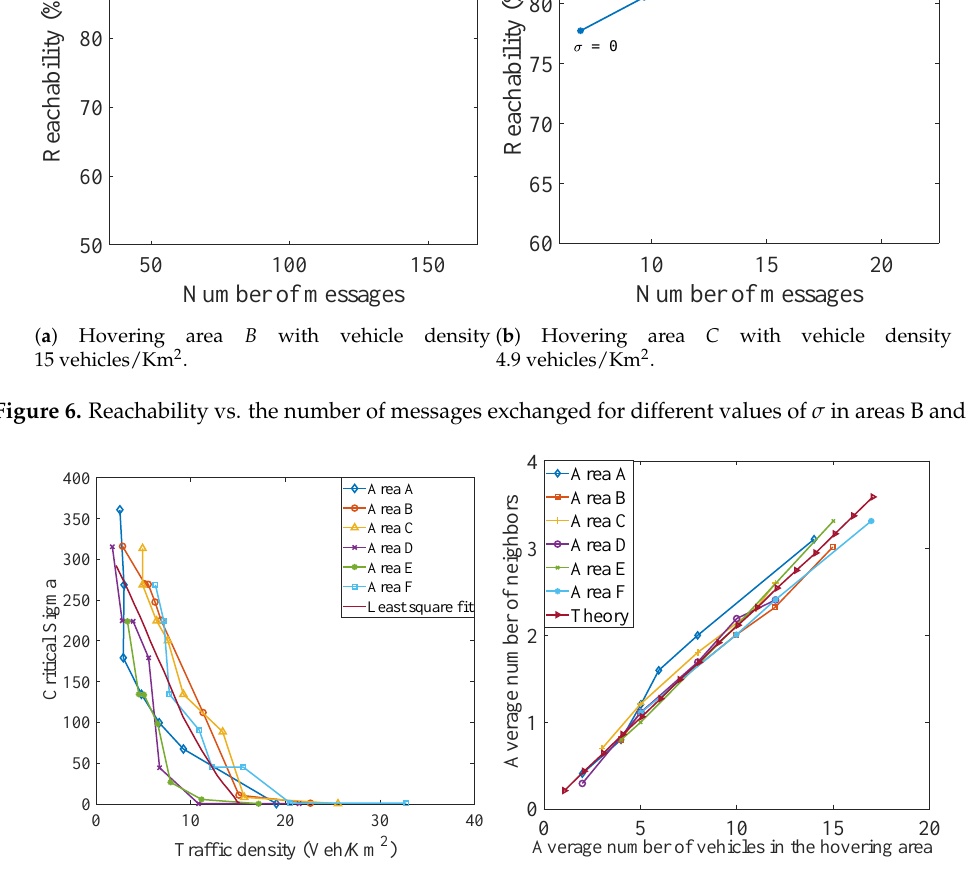
Figure 7. ( a ) Critical value of sigma vs. traffic density in different hovering areas together with their least squares curve. ( b ) Average number of neighbors in different hovering areas and average number of vehicles, and comparison with the predicted values using Equation